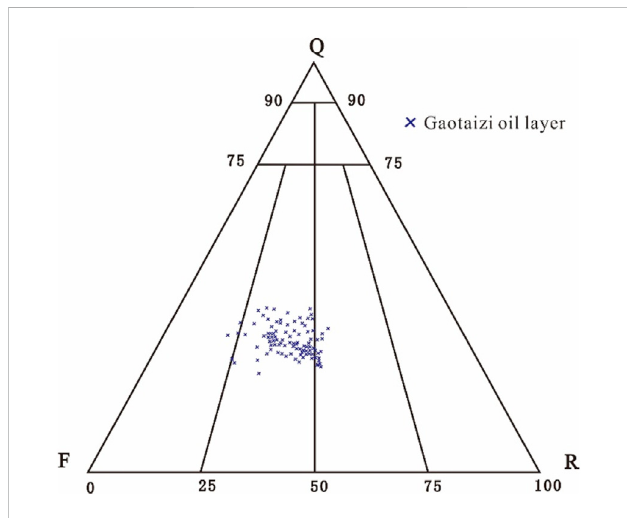
FIGURE 2 Classi fi cation of sandstones of Gaotaizi oil layer in Qijia